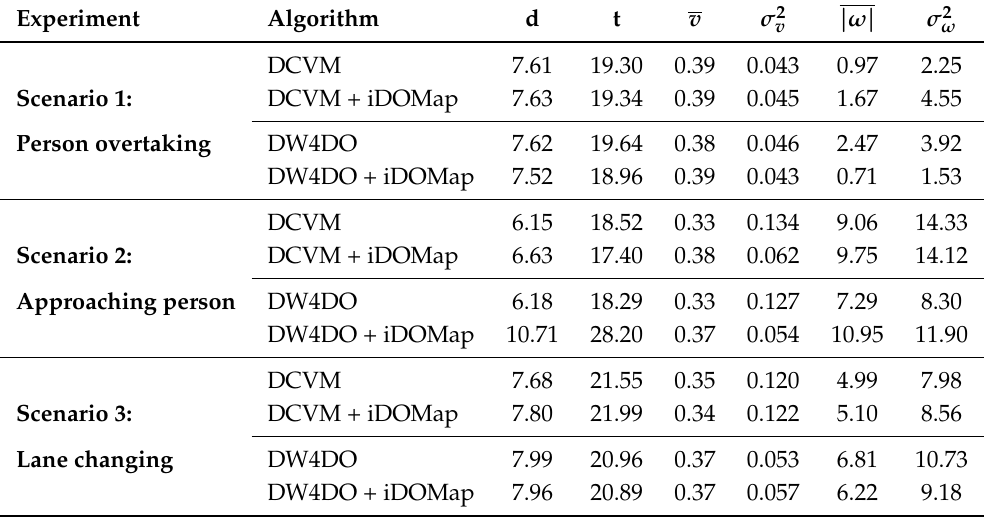
Table 8. Real experiments: